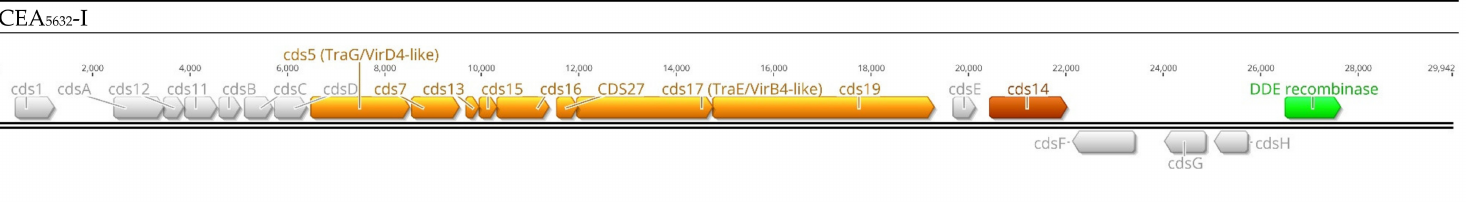
Figure 2. Schematic representation of integrative and conjugative elements from different BRD bacterial species. Genes are represented as arrows, with the arrowhead indicating the direction of transcription. ICE size can be read from the base pair scale on each figure (grey numbers). Pasteurellaceae ICE (A–E): red, antimicrobial resistance genes (ARG); blue, integrase ( int1 or int2 ); purple, relaxase ( rel1 or rel2 ); dark green, DNA replication genes ( parA , parB , dnaB , and topB ); light green, transposase ( tnpA ); orange, conjugative transfer ( traB , traC , traD , and traG ); grey, other CDS. ICE-core genes and ARG were annotated as per [18,83] (Geneious v.10.2.6). ICE Bt _190, ICE from B. trehalosi USDA 190 (CP006956.1); ICE Hs _53A, ICE from H. somni 53A (adapted from Ref [18]; PRJNA605035); ICE Mh1 , ICE from M. haemolytica 42548 (CP005383.1); ICE Pmu1 , ICE from P. multocida 36950 (CP003022.1); ICE Pmu _3358, ICE from P. multocida 3358 (CP029712.1). Mycoplasma agalactiae 5632 ICEA-I (F) (CT030003.1): light green, transposase; light orange, CDS candidates for conjugative channel (CDS5-19); dark orange, CDS14 has a key role in ICE and chromosome transfer [21]. * Partial